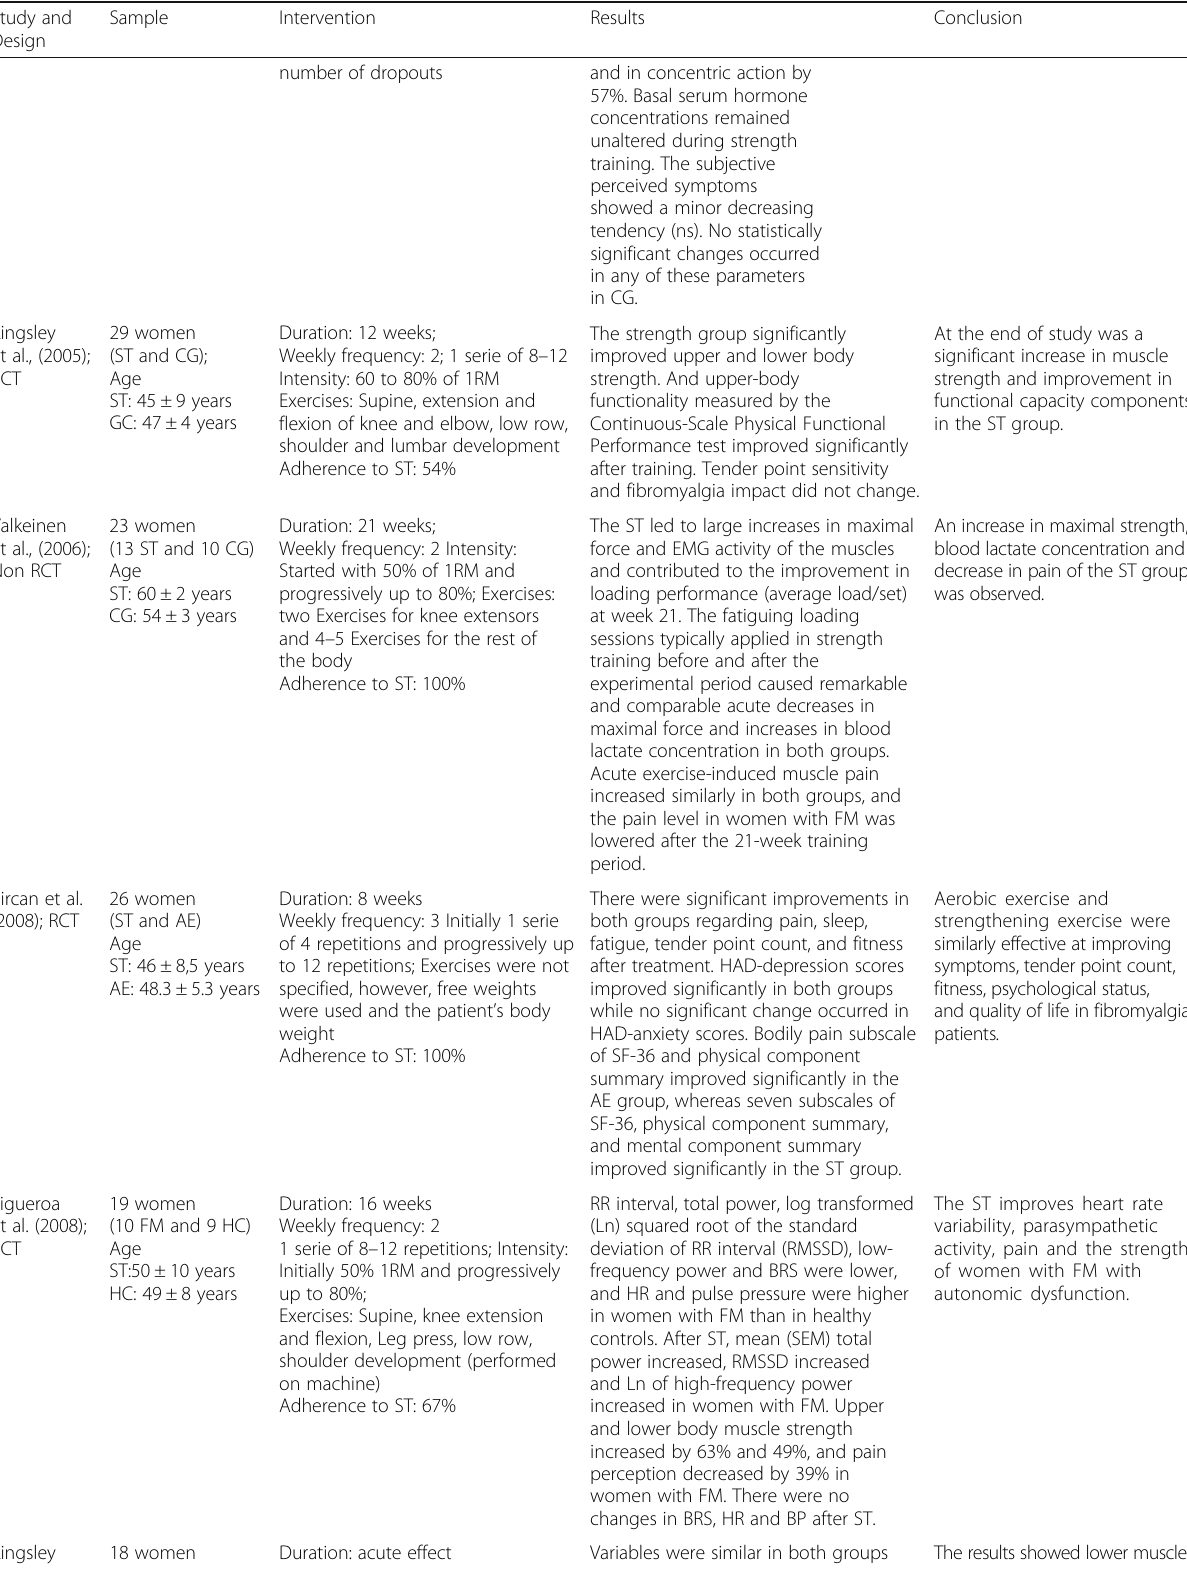
Table 2 Characteristics and results of experimental studies with strength training for patients with fibromyalgia syndrome (Continued) Study and